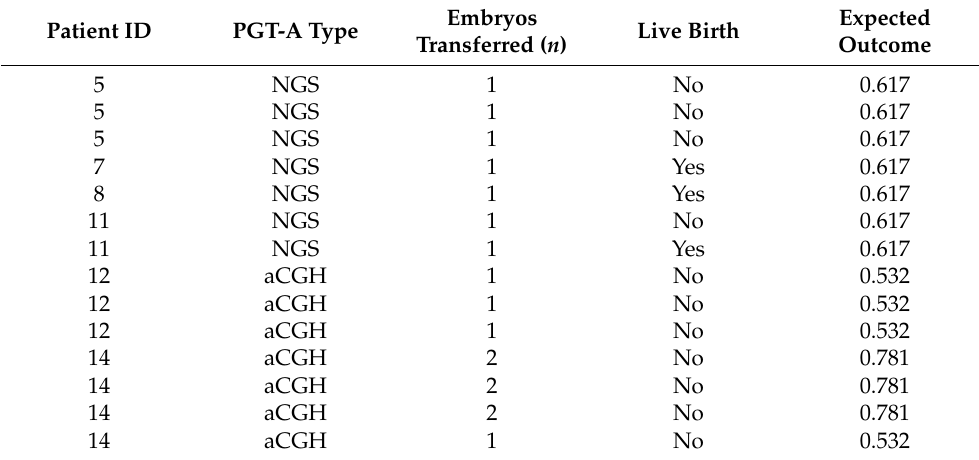
#14. Table 3. Embryo transfer outcomes for euploid Table 3. Embryo transfer outcomes for euploid embryos.